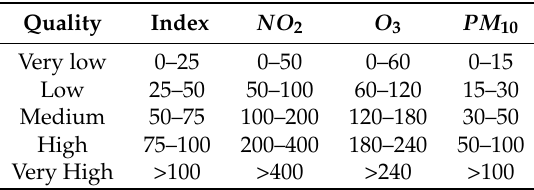
Table 5. Common Air Quality Index (CAQI) reference table. Indices of individual pollutants correspond to hourly concentrations ( µ g/m 3 ), except for the 24-h index for PM 10 . The common index is defined as the worst quality among